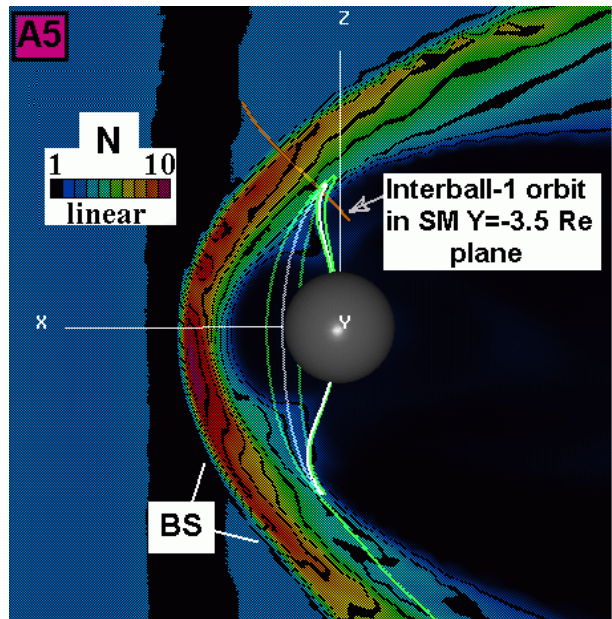
Plate A5. The plasma density from the global MHD model by Fed- der et al. (1995) on the Y = − 3 . 5 R E plane and field lines through Interball orbit at 03:14UT (white) and ± 0 . 25 R E around the central field line (green). The MSH corresponds to the density maximum between the BS and empty magnetosphere. On the closed magne- tospheric lines (white and inner green ones) density enhancements are seen sunward of these kinked lines (which are mostly out of the semi-transparent density plane). The green field line farthest from the Earth is the reconnected